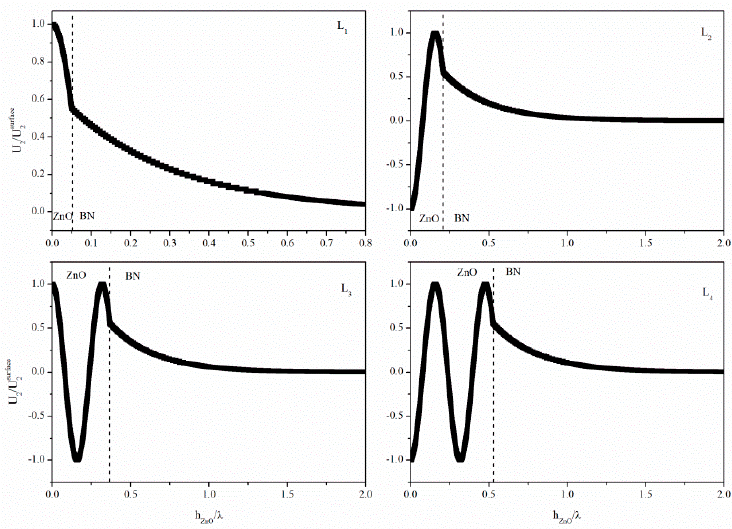
Figure 9. The particle displacement component of the first four Love modes travelling at a common velocity of 9318 m/s along different ZnO layer thicknesses ( h / λ = 0.050, 0.209, 0.369 and 0.528, respectively).